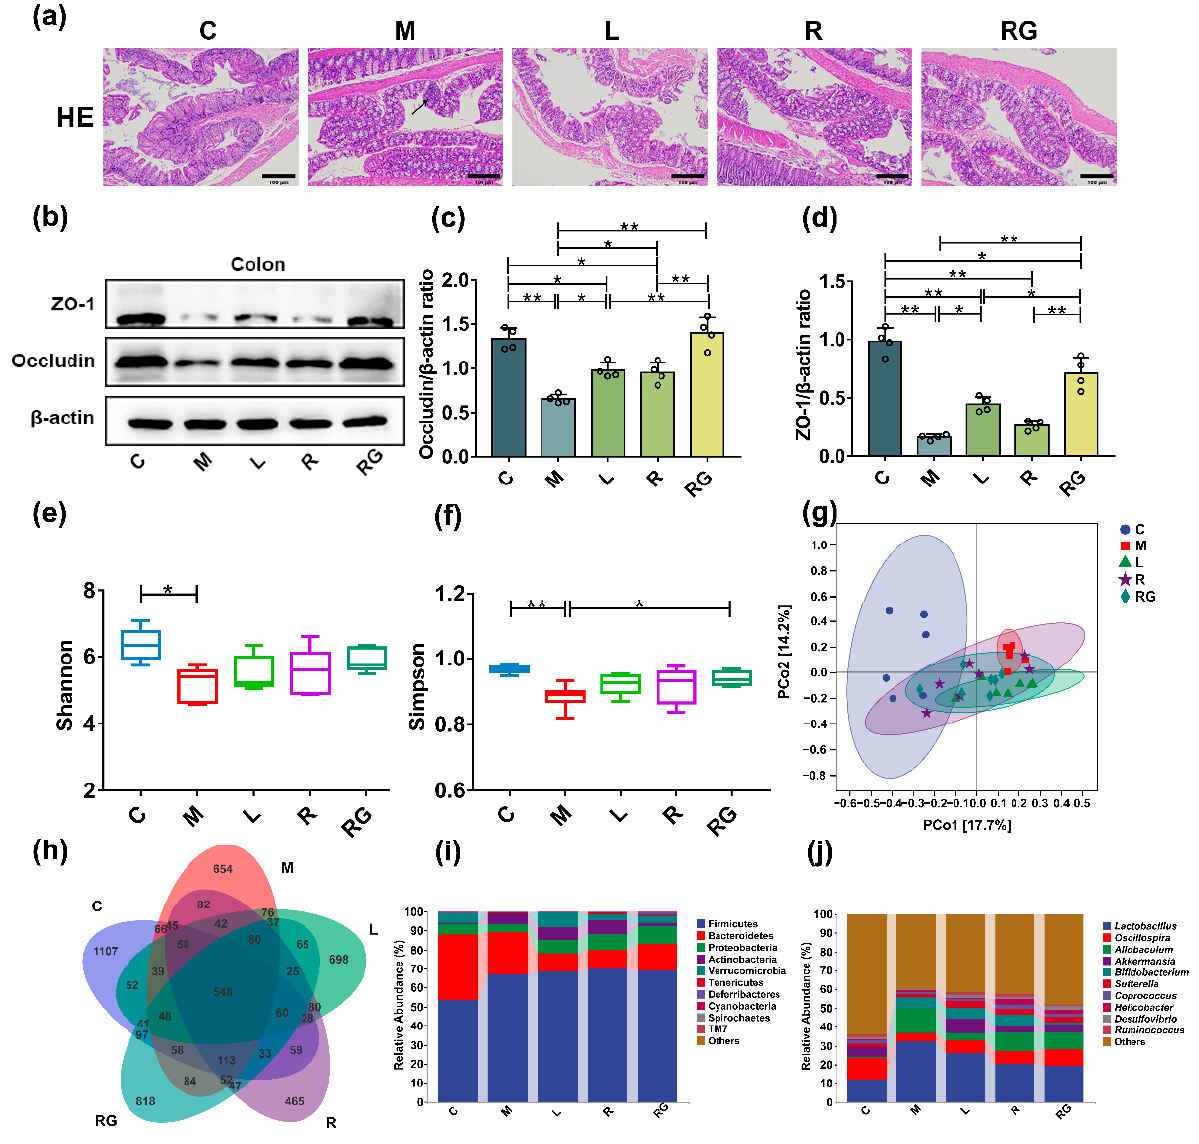
Figure 6. L. lactis MG1363-pMG36e-GLP-1 improved intestinal barrier and reversed dysbacteriosis in PD model mice. ( a ) Representative images of H and E staining in colon; → : inflammatory infiltration (scale bar = 100 µ m). ( b ) Western blotting of ZO-1, occludin, and β -actin in colon. ( c , d ) Relative quantification of ZO-1 and occludin protein levels adjusted internal reference to β -actin ( n = 4). ( e ) Shannon index. ( f ) Simpson index. ( g ) PCoA analysis. ( h ) Venn chart. ( i ) Abundance analysis at phylum level. ( j ) Abundance analysis at genus level. C group ( n = 6), M, L, R, and RG group ( n = 7). * p < 0.05 and ** p < 0.01.